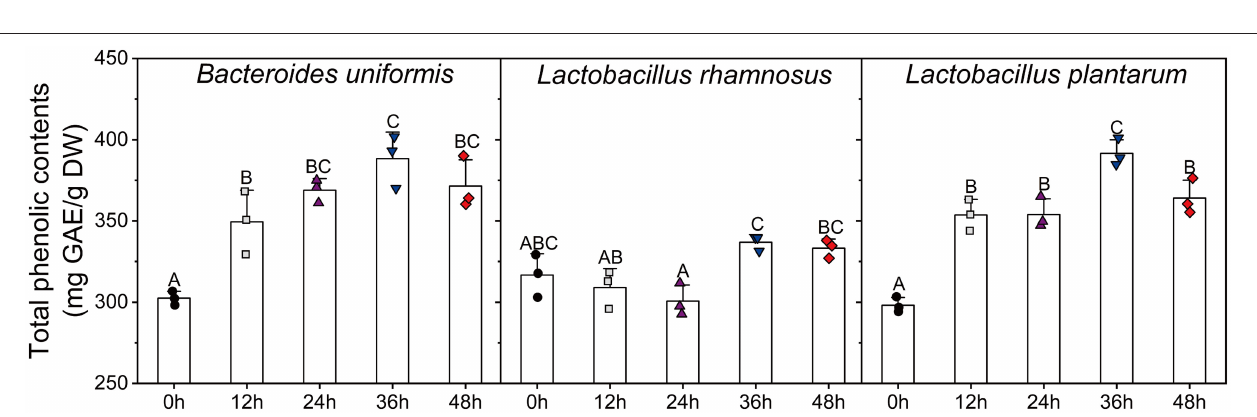
FIGURE 5 | Changes in the total phenolic contents of the supernatants of different microbial cultures ( B. uniformis , L. rhamnosus and L. plantarum ) during fermentation with lychee pulp phenolics (LPP). Bars with no letter in common are significantly different ( p <